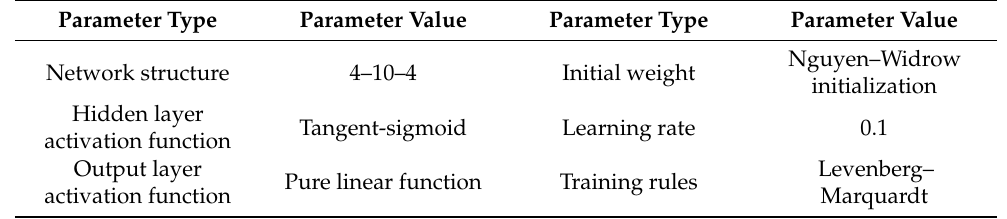
Table 1. Neural network structure and parameter settings for the experiments in this